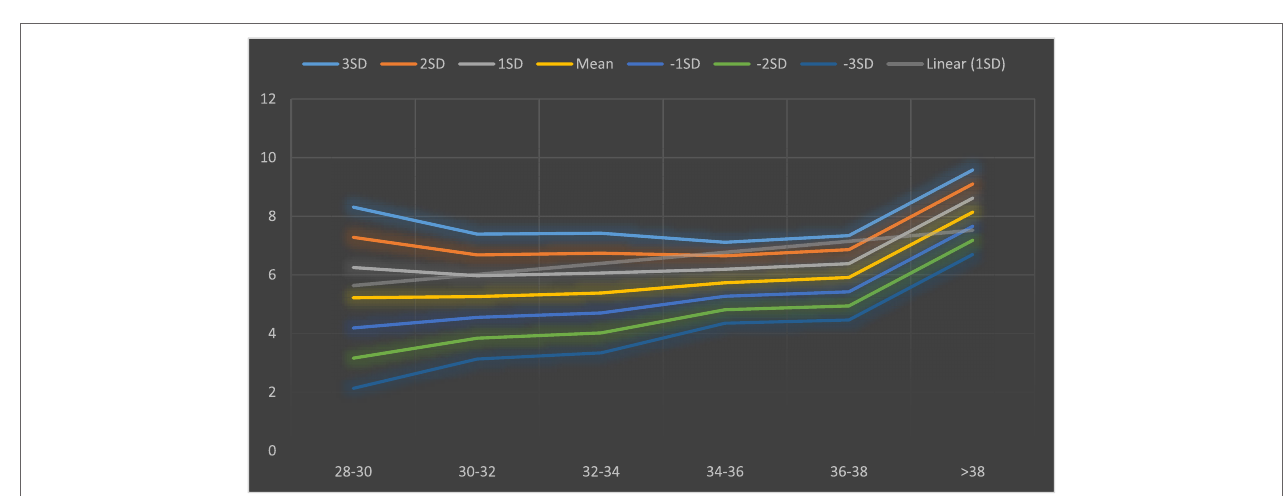
FigUre 2 | Mean and SD of penile circumference (PC) based on different gestational age of neonates.